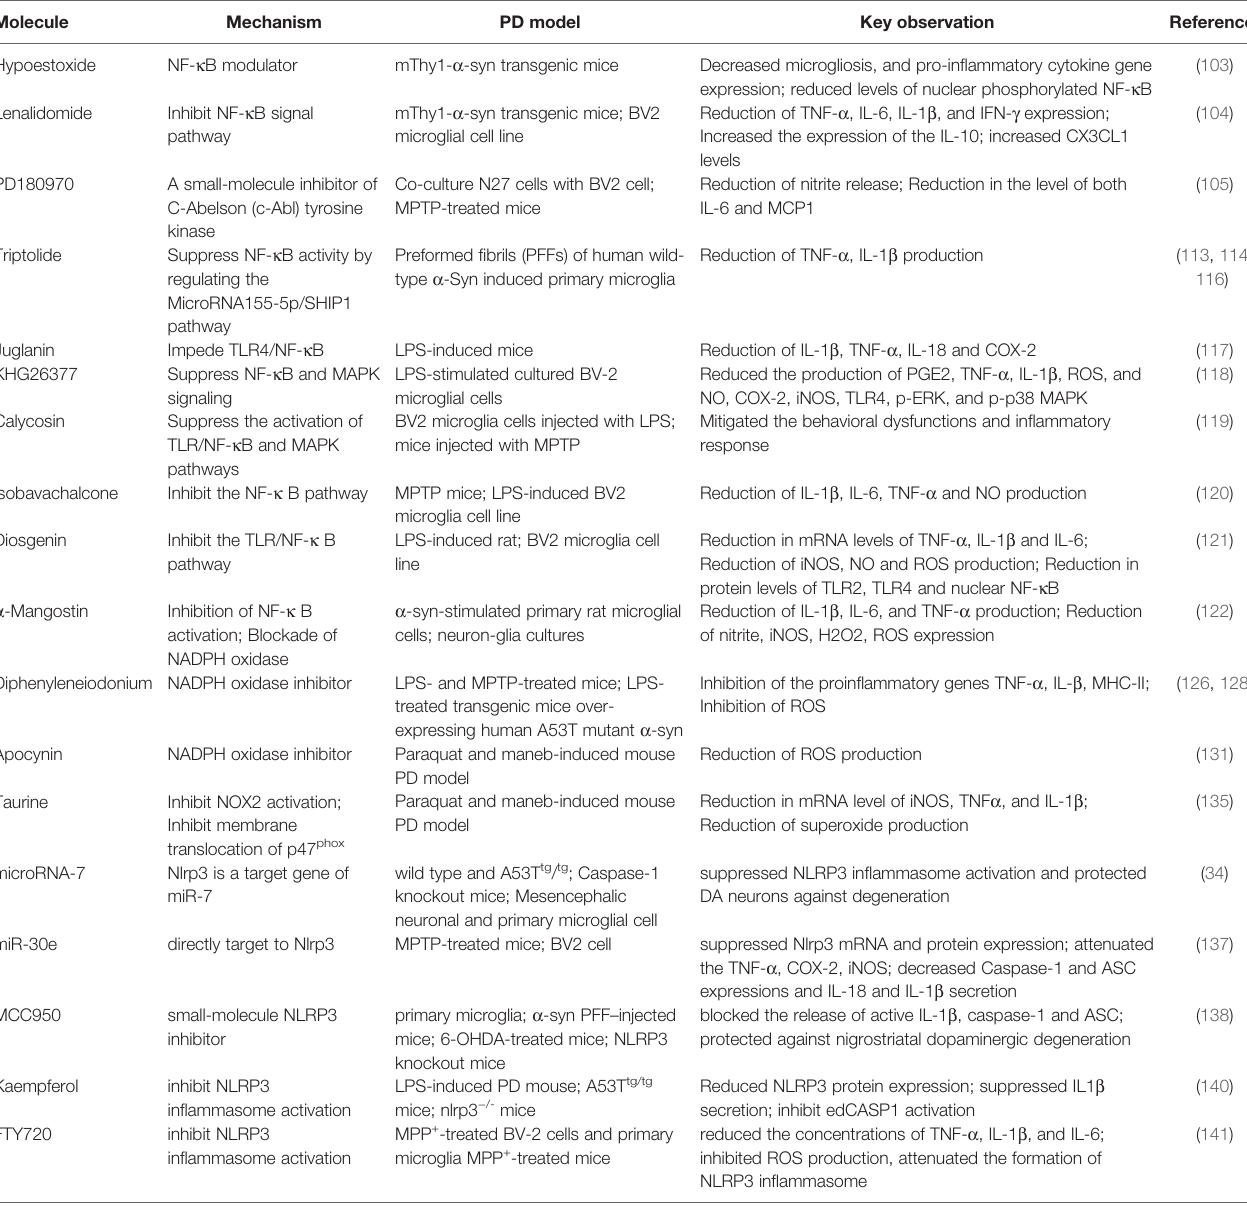
TABLE 4 | Molecules targeting NLRP3 and two signals of NLRP3: NF- k B pathway and synthesis of ROS. Molecule Mechanism PD model Key observation